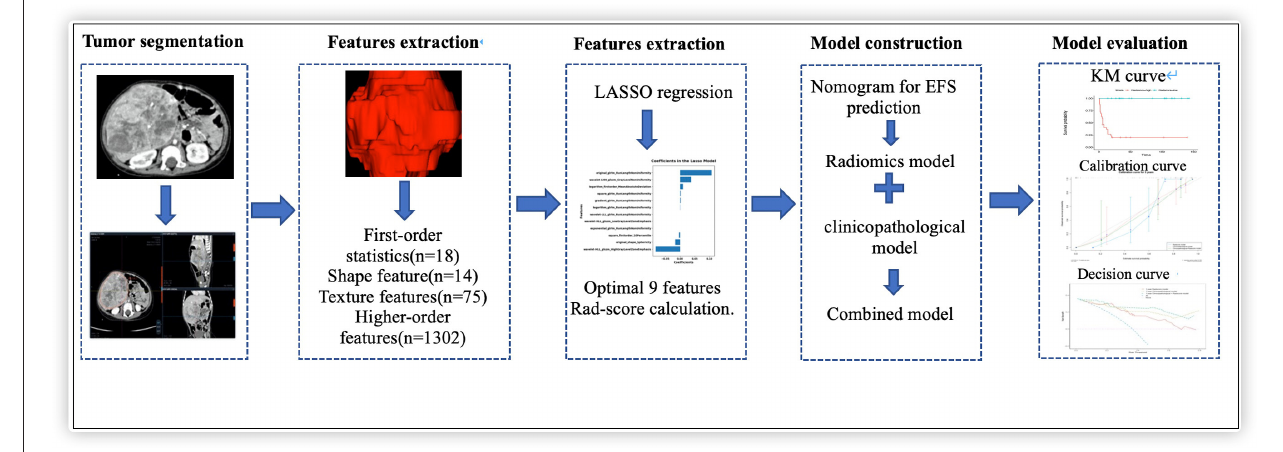
FIGURE 1 | Radiomics framework of predicting the EFS of patients with